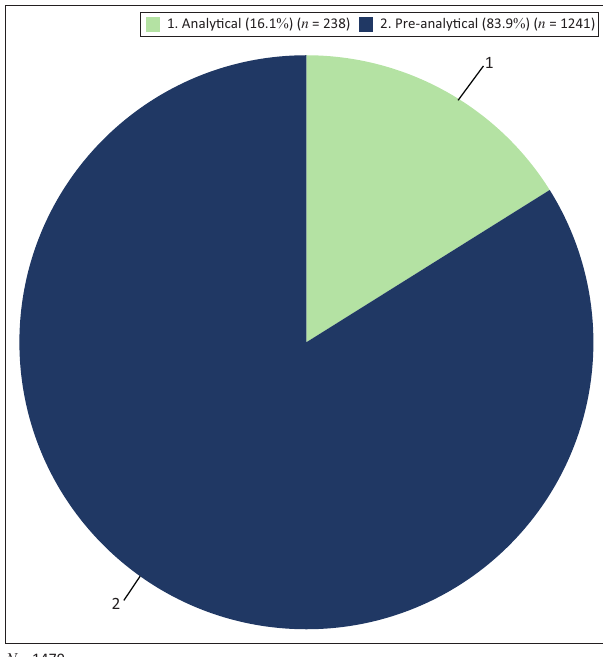
FIGURE 1: Pre-analytical and analytical reasons for HIV polymerase chain reaction test rejection at Tygerberg Hospital, Cape Town, South Africa,